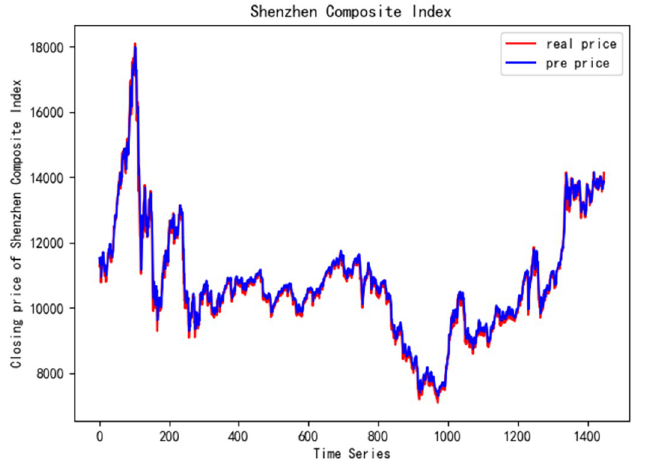
Fig 5. Closing price of Shenzhen Composite Index.